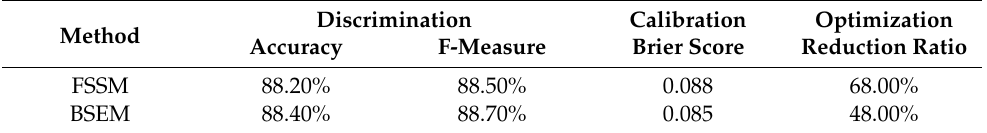
Table 6. Performance of FSSM and BSEM with the training dataset.